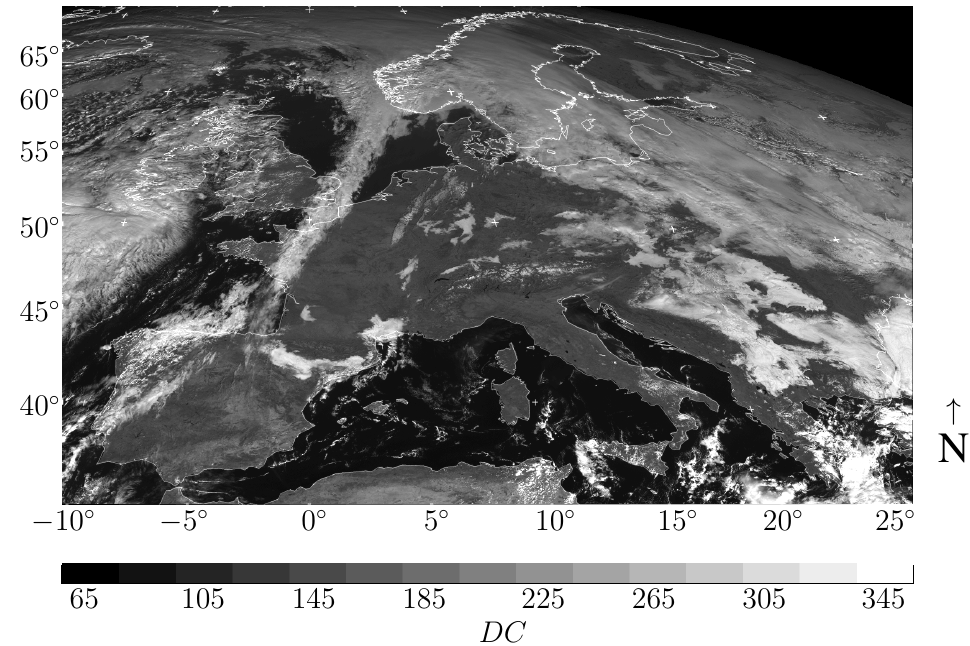
Figure 1. HR-VIS image for Europe, 1 November 2014, 1100 UTC. Digital counts are depicted with enhanced contrast.